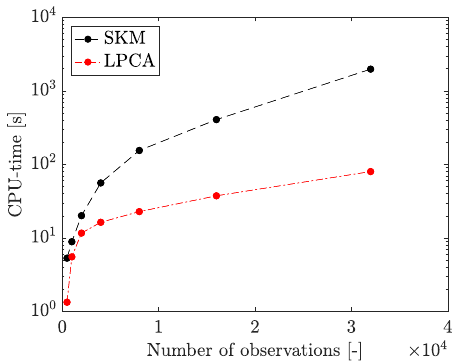
Figure 8. CPU-time (in seconds) required by the SKM algorithm (black dashed lines) and LPCA clustering algorithm (red dashed-dotted line) to reach convergence, varying the size of the training dataset with a constant number of clusters in input ( k = 8).